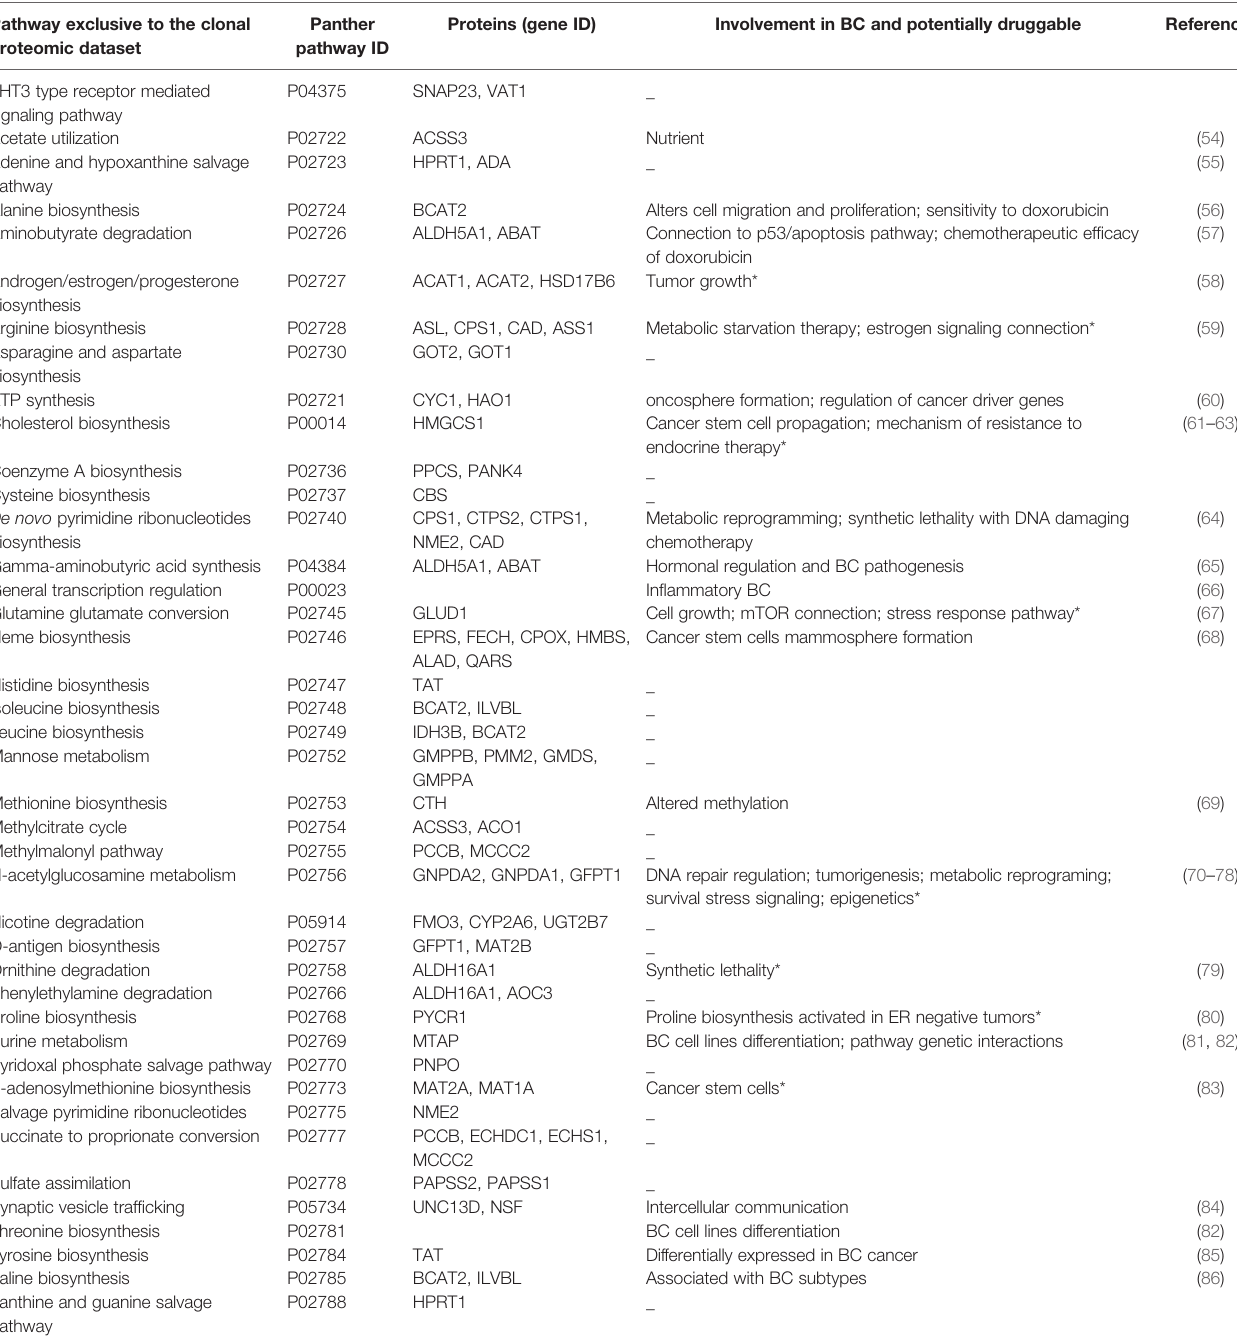
TABLE 2 | Pathways exclusive to the clonal proteomic